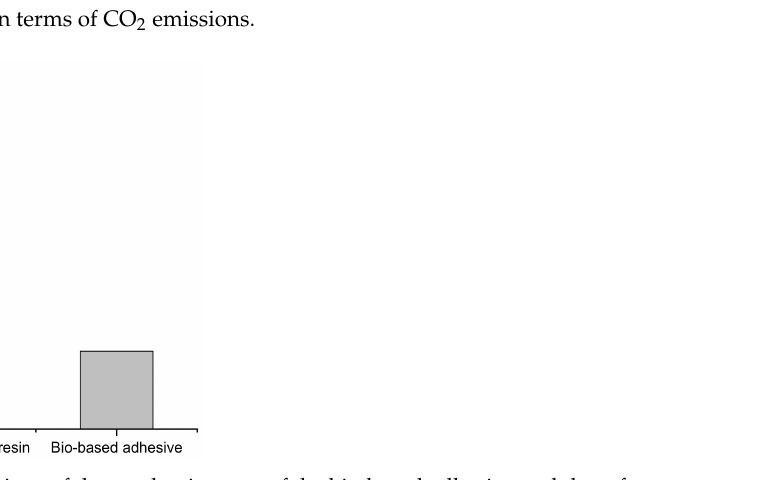
Figure 8. Comparison of the production cost of the bio-based adhesive and the reference epoxy